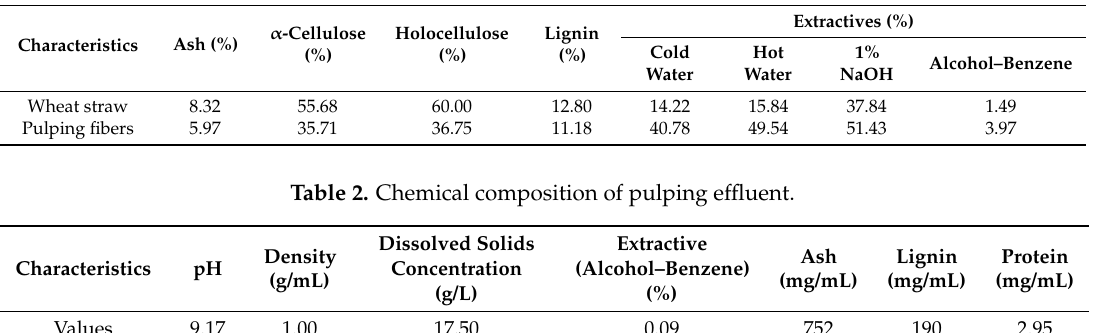
Table 1. Chemical compositions of wheat straw and pulp fibers.